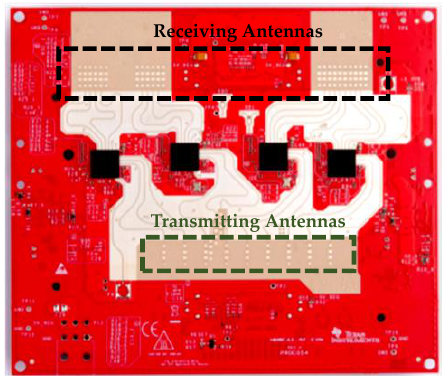
Figure 12. The AWR1243P four-chip cascade radar.